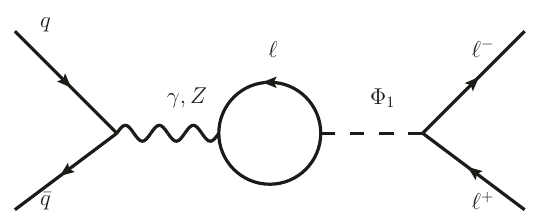
Figure 5 . Feynman diagrams for the Drell-Yan process induced by a vector mediator (cid:8) 1 at the LHC.